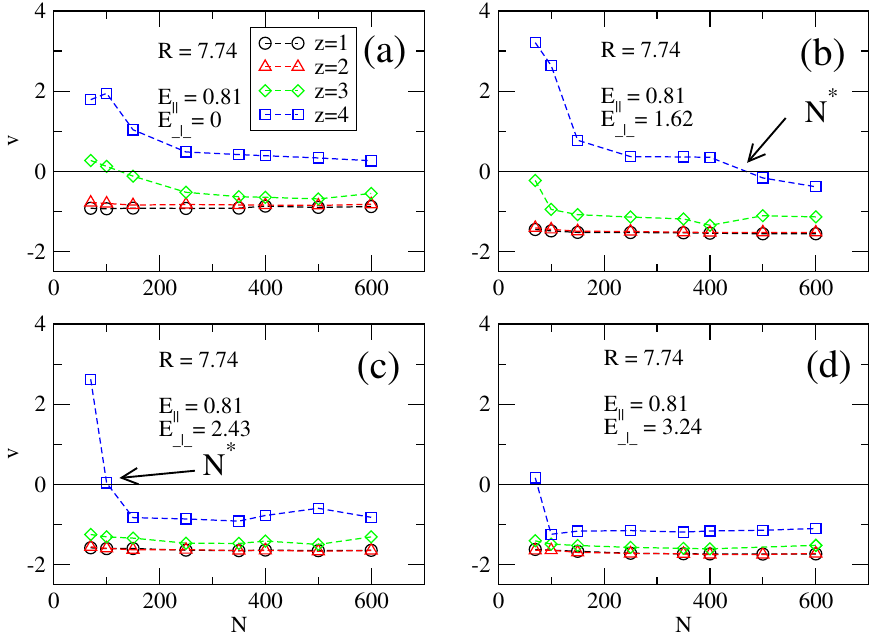
Figure 2. Electrophoretic velocities v as a function of chain length N for ( a – d ) transversal fields E = 0 , 1 . 62 , 2 . 43 and 3 . 24 , respectively. The radius of the cylinder is R = 7 . 74 and ⊥ the longitudinal field is E = 0 . 81 . For clarity of definition, in Figure ( b , c ), we show the k minimum critical chain length N ∗ .